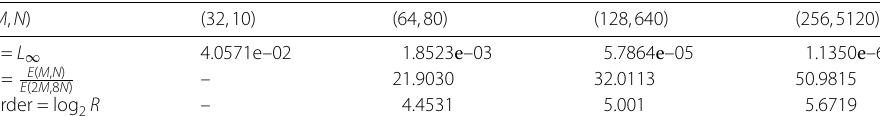
Table 6 Order of convergence of the CCD method for American put options under the Merton model with λ = 0.1